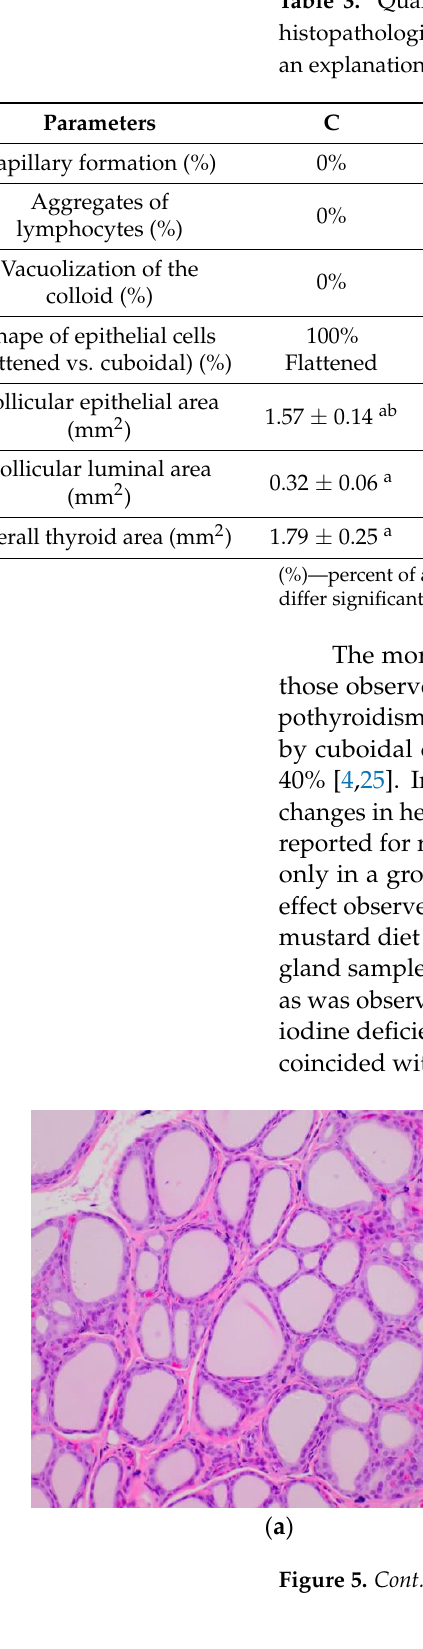
Table 3. Qualitative and quantitative parameters describing the changes observed during the histo- pathological examination of thyroid glands from the investigated rats (see Section 3.4.1 for an ex- planation of the groups’